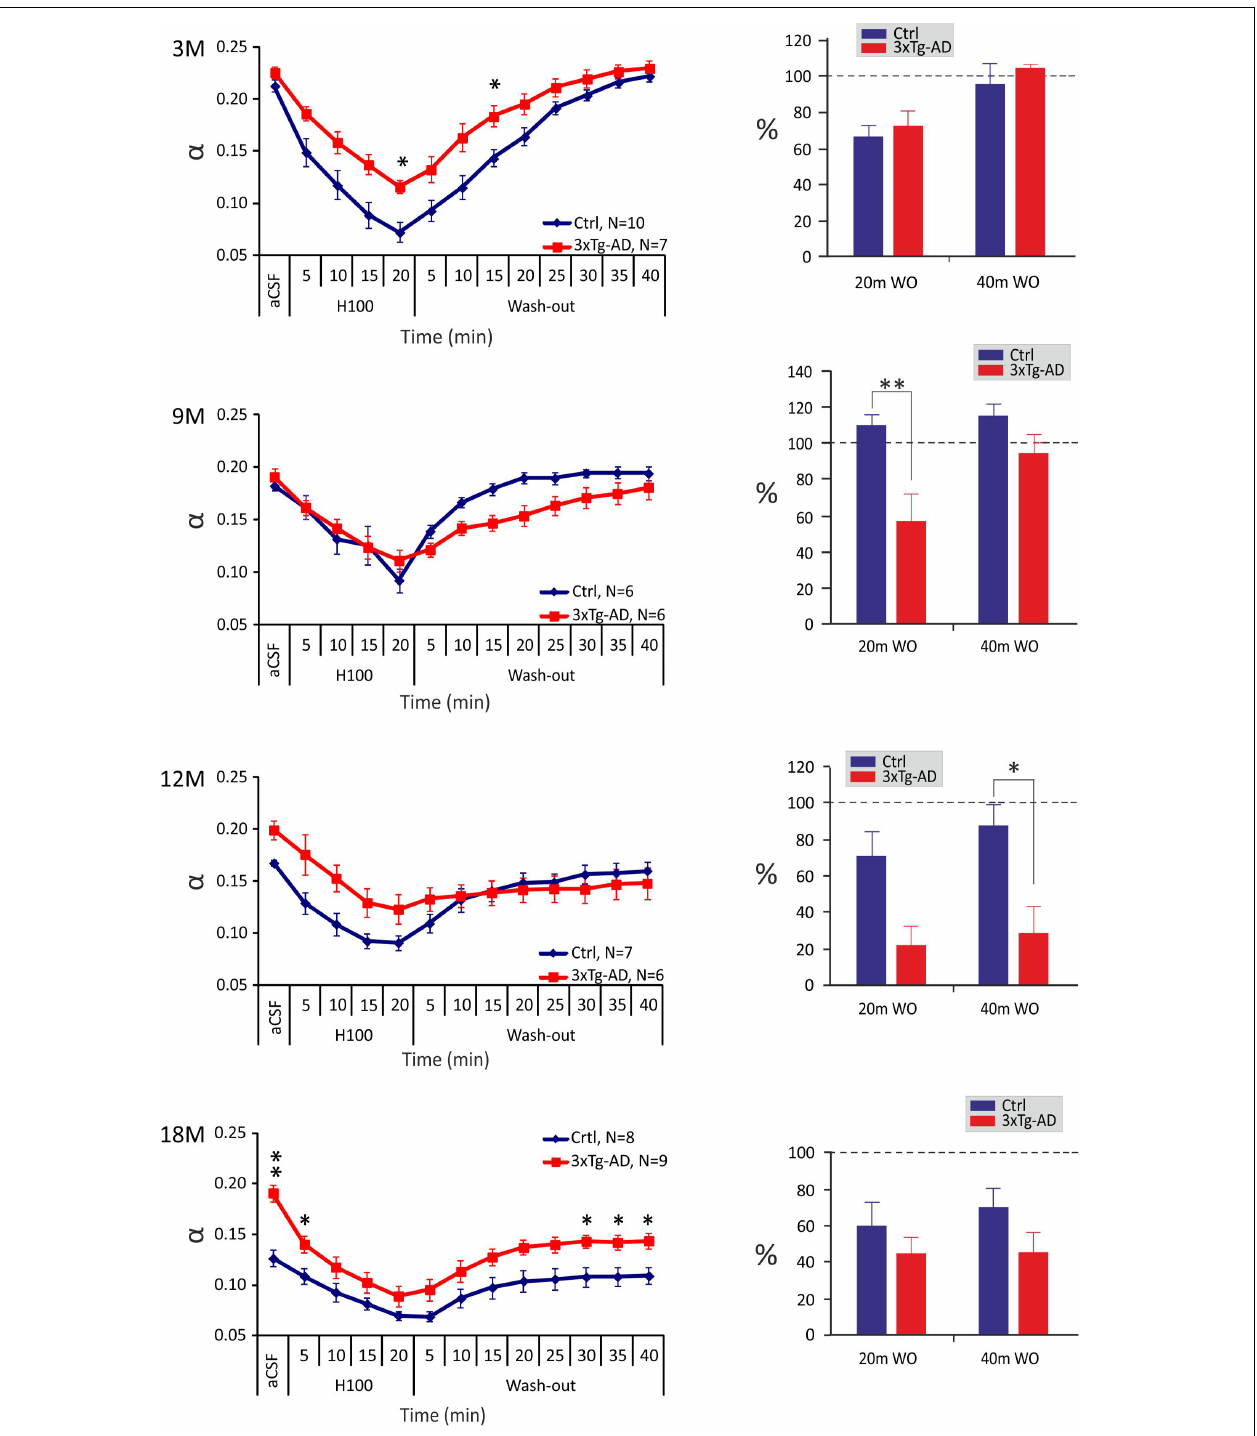
FIGURE 3 | Age-dependent changes of the absolute values of the ECS diffusion parameters in control and 3xTg-AD mice evoked by hypo-osmotic stress. The left side: Time course of the volume fraction ( α ) changes during a 20-min application of aCSF H − 100 and a 40-min washout in 3-, 9-, 12- and 18M-old control animals and age-matched 3xTg-AD mice. The right side: Volume fraction recovery during washout at 20 min intervals is expressed as changes in the values reached in the 20th min of application, set as 0%. Data are presented as mean ± SEM. Statistical significance was determined by two-way ANOVA test with Tukey’s post hoc test. Asterisks indicate significant differences between Ctrl and 3xTg-AD mice ( ∗ p < 0.05, ∗∗ p < 0.01). Ctrl, control mice; 3xTg-AD, triple transgenic model of AD; aCSF, artificial cerebrospinal fluid; H100, hypotonic artificial cerebrospinal fluid; WO, wash-out; 3M, 9M, 12M, 18M, 3-, 9-, 12-, 18-month-old animals; N, number of